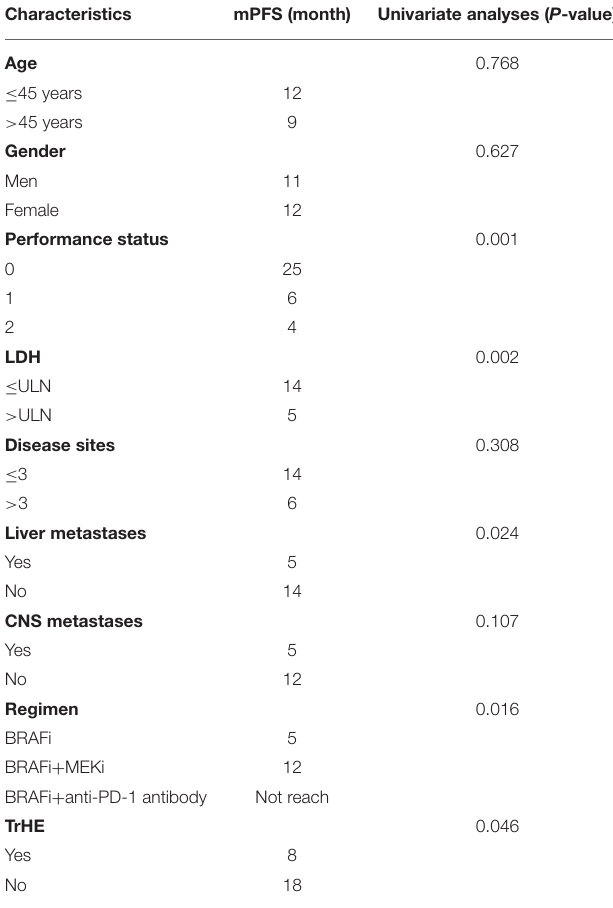
TABLE 3 | Univariate analyses of prognostic factors for PFS in patients with malignant